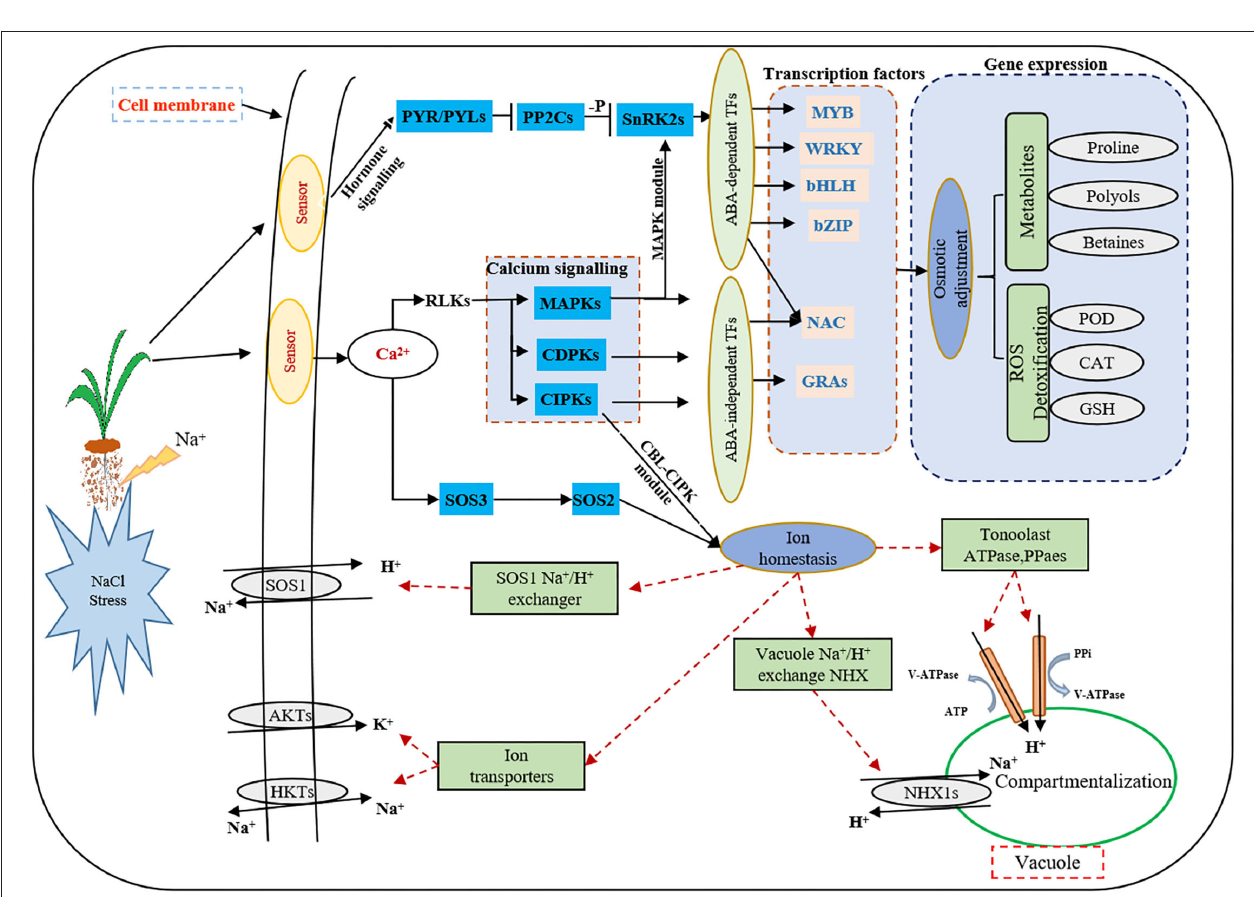
FIGURE 8 | Model describing the signal transduction pathways involved in the acquisition of salt tolerance in smooth bromegrass. Red dashed lines indicate proposed regulation, solid arrowheads indicate activation, and vertical solid lines indicate suppression.